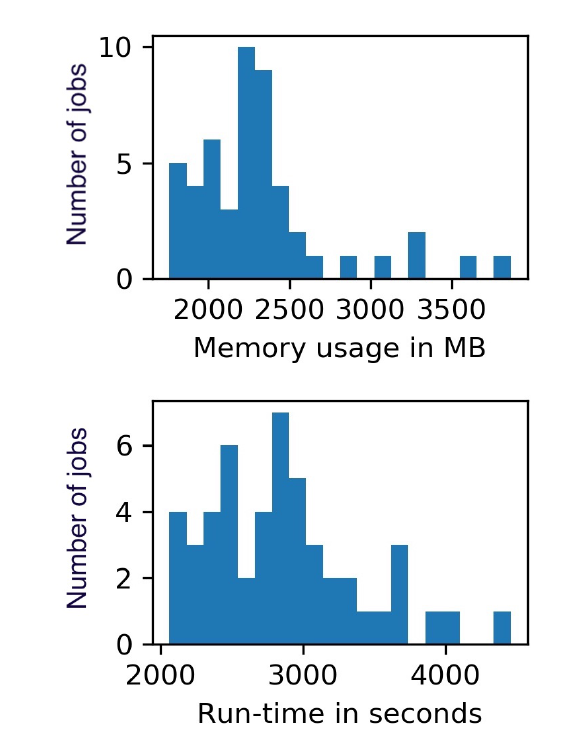
Figure 4. Histograms for the